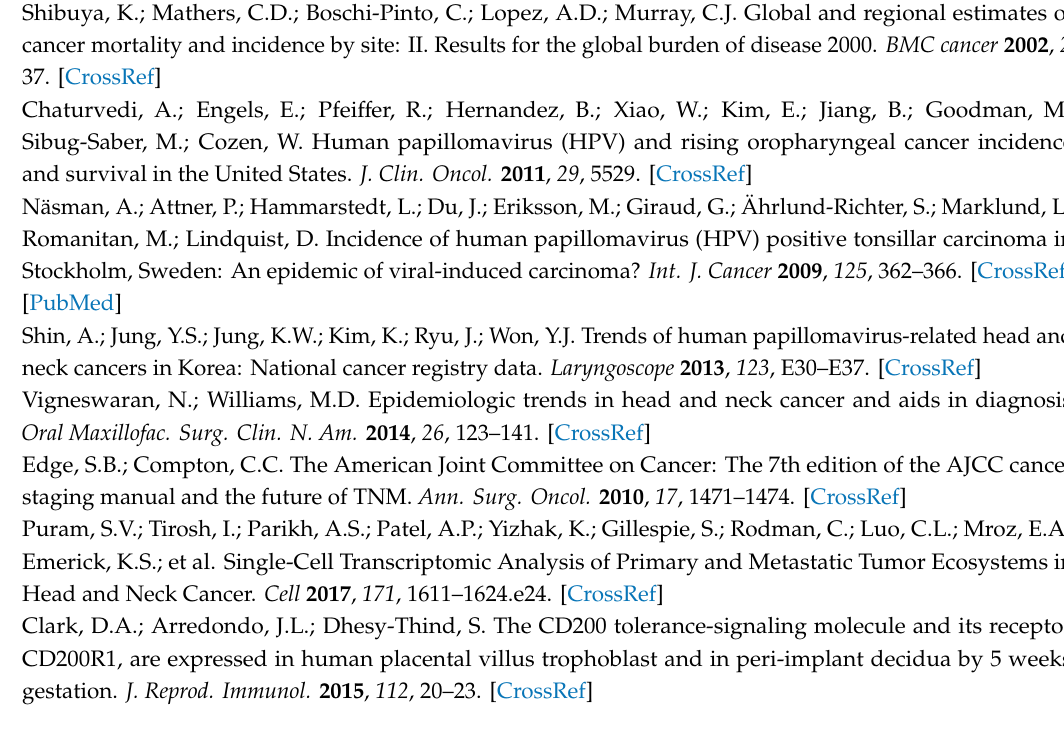
Figure S1: The CD200 expression in metastatic HNSCC patients, Figure S2: The EMT features in endogenously CD200-expressing NTERA cell, Figure S3: Sphere formation and cisplatin-responsiveness of CD200-overexpressing MEER cell, Figure S4: Adenovirus over-expressing soluble extracellular domain of CD200, Figure S5: Abolition of β -catenin target genes by CD200 siRNA in CD200 endogenous expression cell, Figure S6: PCR primer, Figure S7: Whole blots showing all the bands of Western blotting presented in Figure 1B–E, Figures 2C, 3A, 4A, 4B, 4E and 4F, and Supplementary Figures 2A, 4B,